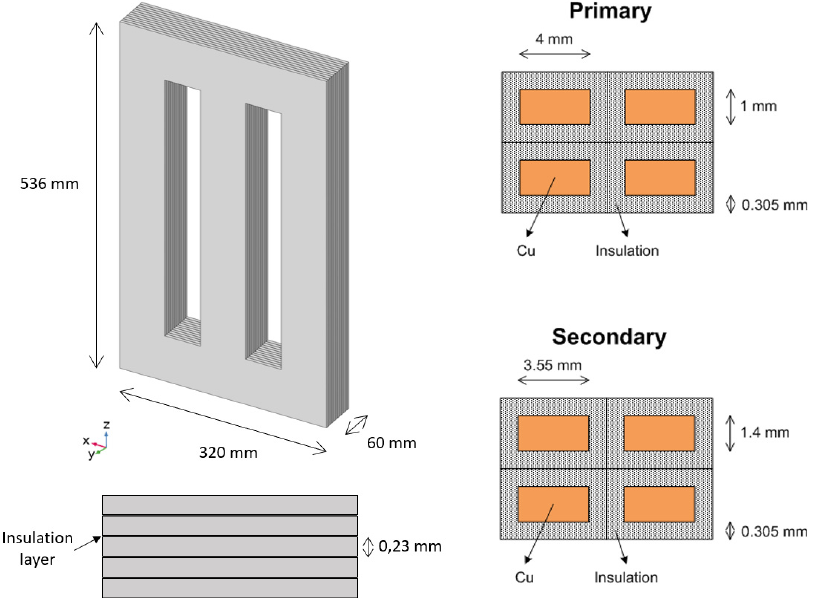
Figure 7. Schematic view of the core laminated sheet, including a detail of the sheet in the transversal direction and cross-section of the wiring in the primary and secondary. The scaling and the number of layers are schematic and do not correspond to reality.